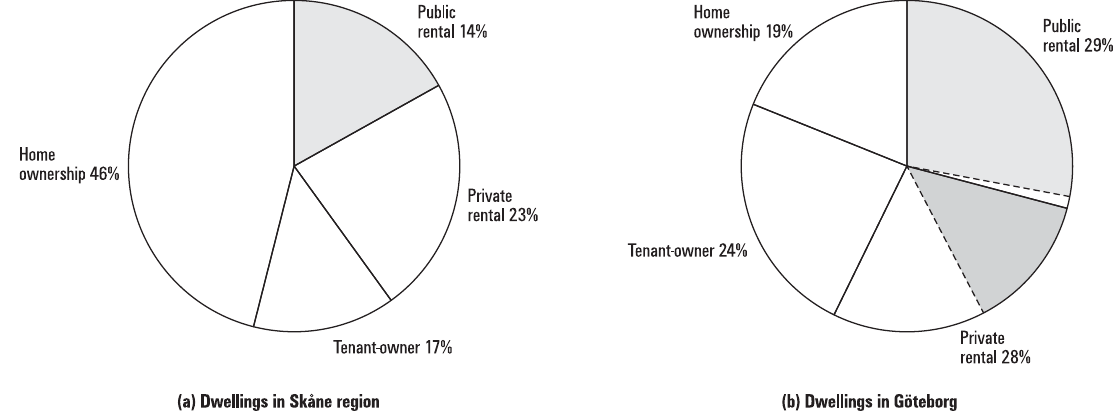
Figure 1 . Total dwelling stocks in (a) the Skåne region and (b) Göteborg, divided into four categories Coloured parts are included in the survey